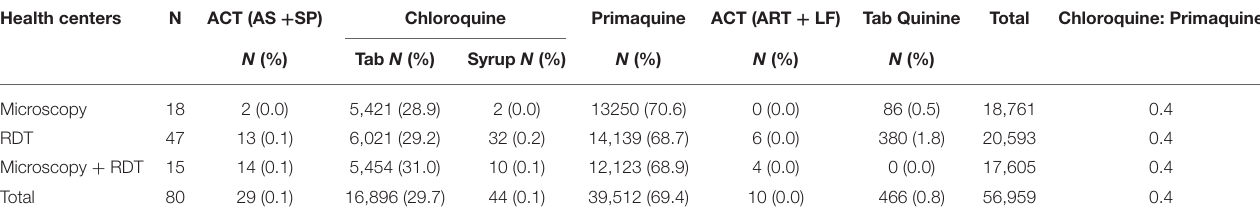
TABLE 5 | Malaria treatment in RDT health centers. Health